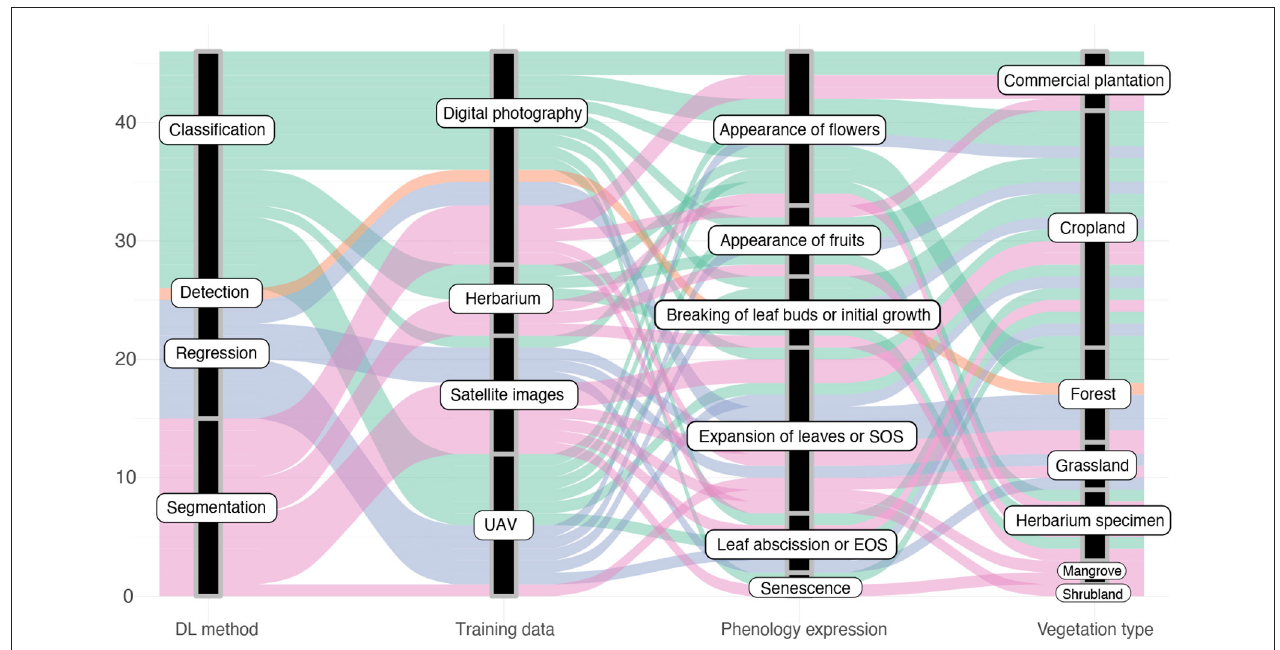
FIGURE 8 | Diagram describing articles according to the defined